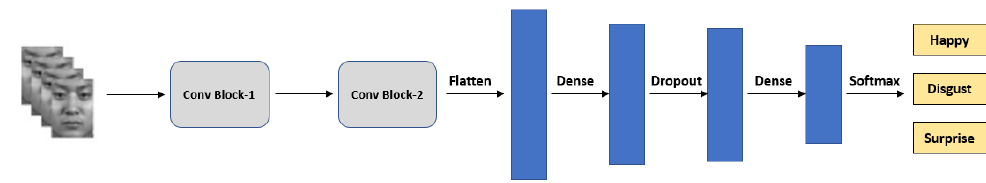
Figure 2. Architecture of our proposed 3D CNN Model-A.